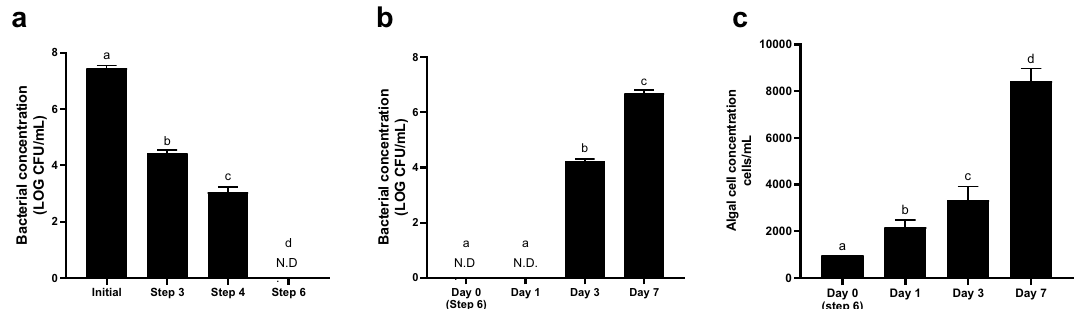
Figure 6. Bacterial removal in the Alexandrium tamarense (AT6) samples using the basic protocol. ( a ) Total bacterial count against different steps. Initial: the initial bacterial count present in AT6 at the beginning. ( b ) Total bacterial count in the AT6 culture obtained after the protocol at different days of cultivation. ( c ) Algal cell concentration during the regrowth of the AT6 culture obtained after the protocol. All data are presented as means ± standard deviations of three independent experiments (n = 3). N.D.: not detected. Different letters on the top of the bar indicate that means were significantly different among different samples at p ≤ 0.05 according to one-way analysis of variance followed by Tukey multiple comparison